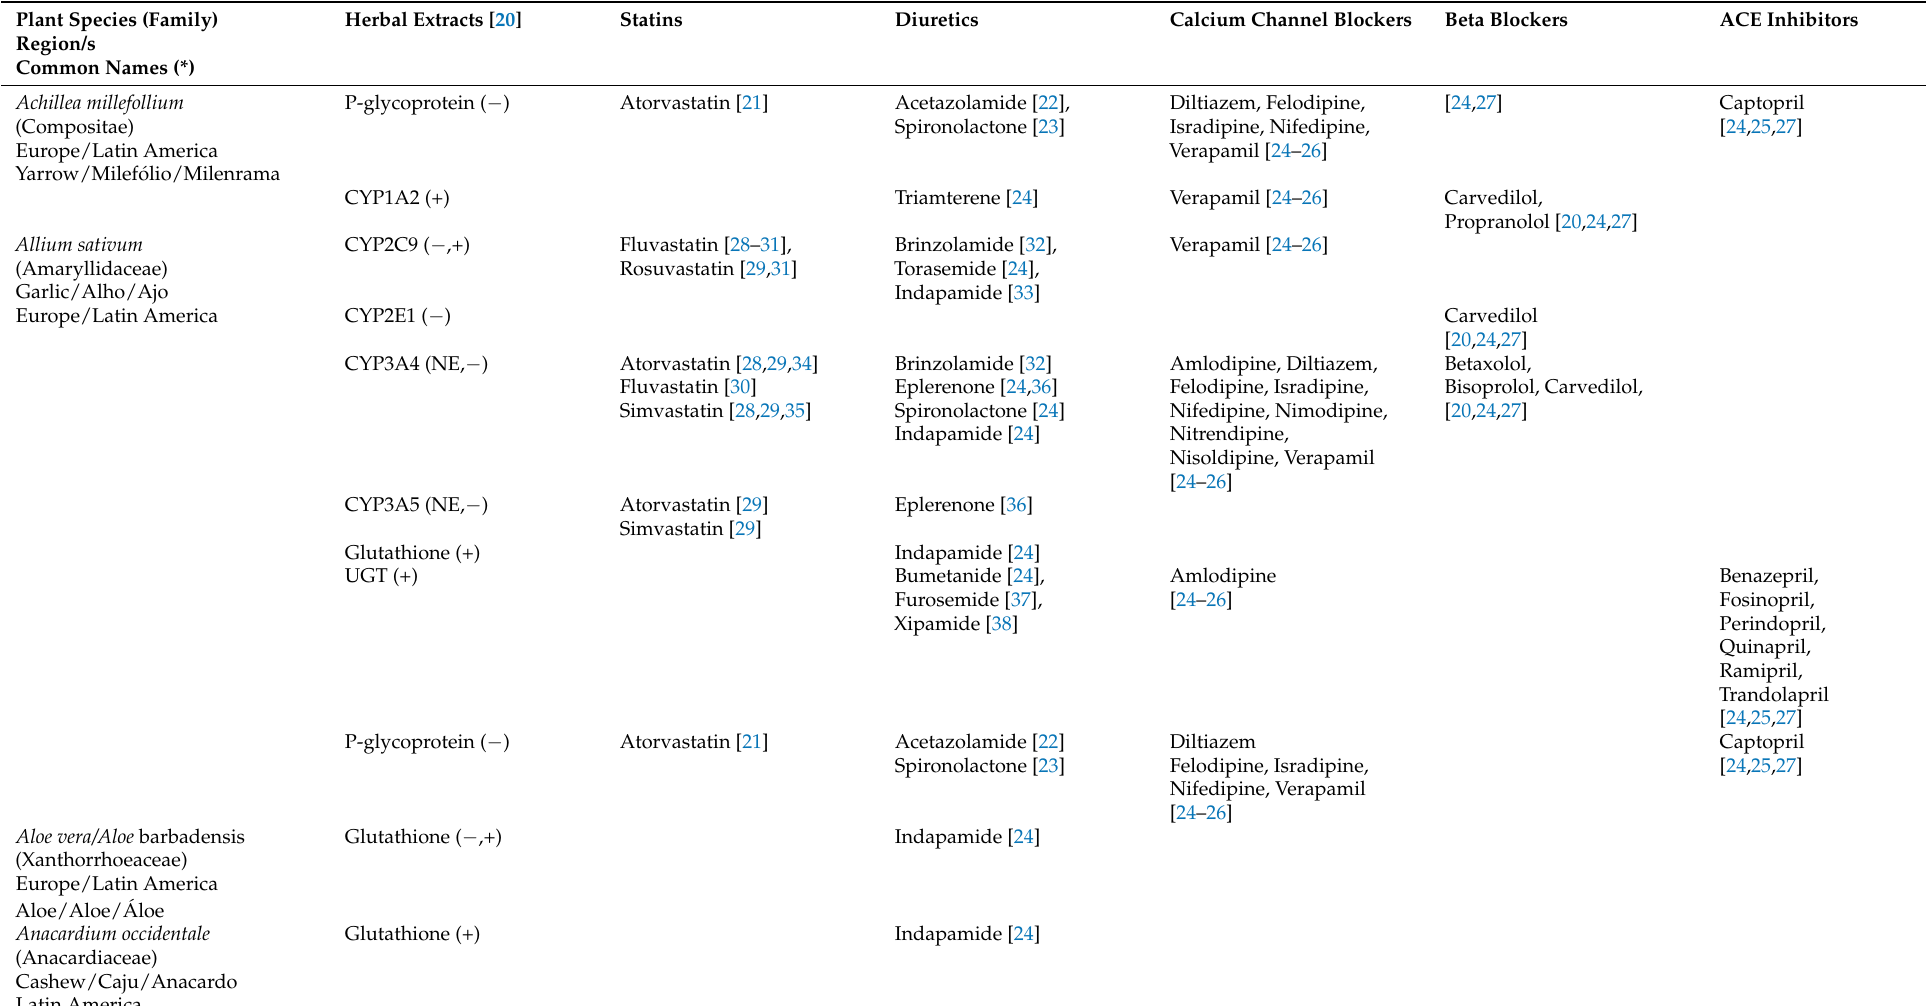
Table 1. Cross map of documented effects of medicinal plant extracts and studied cardiovascular drugs on P-glycoprotein (P-gp), Phase 1 enzymes and Phase 2